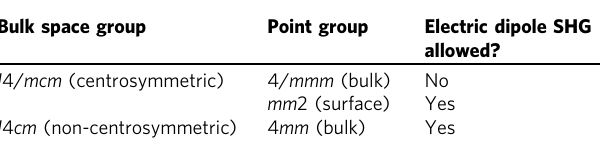
Table 1 Space groups and corresponding point groups